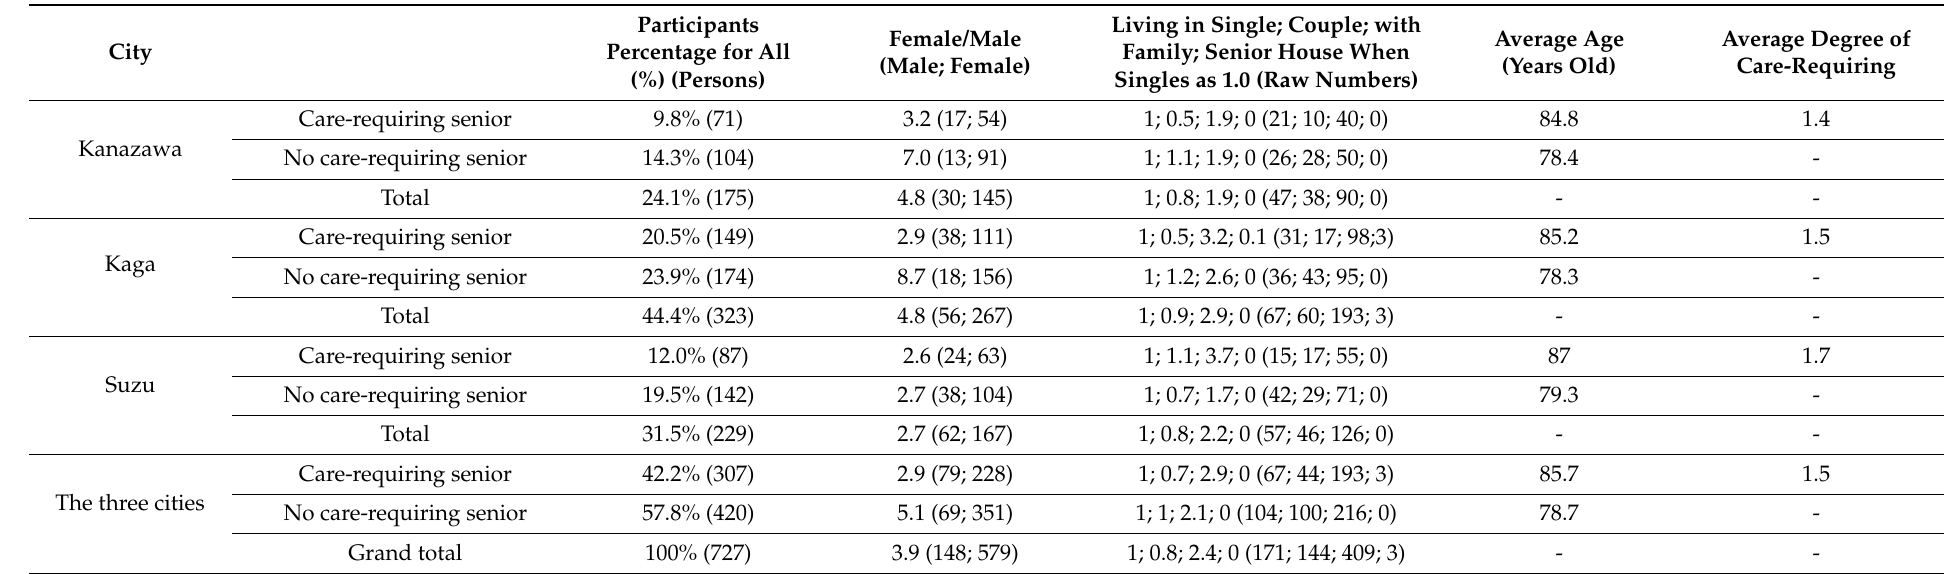
Table 3. Characteristics of participants in three target